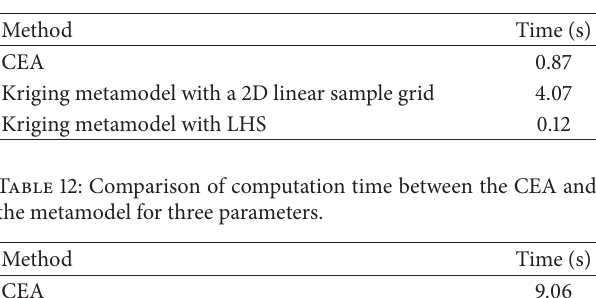
Table 11: Comparison of computation time between the CEA and the metamodel for two parameters.